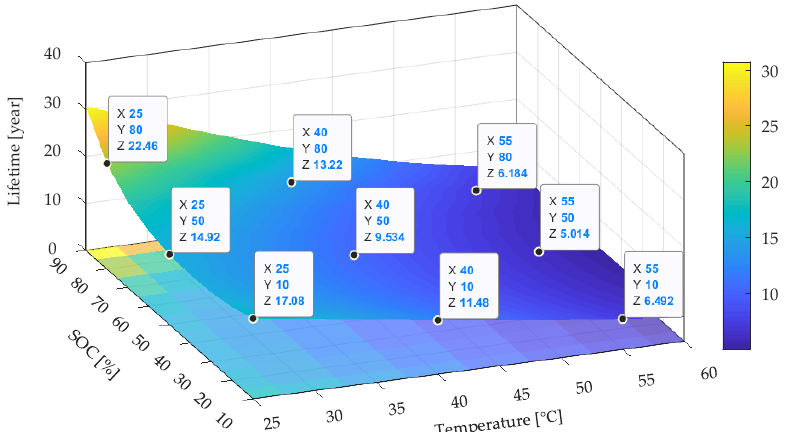
Figure 19. Lifetime prediction results using the established resistance increase model (when 100 % resistance increase EOL criterion has been reached ).